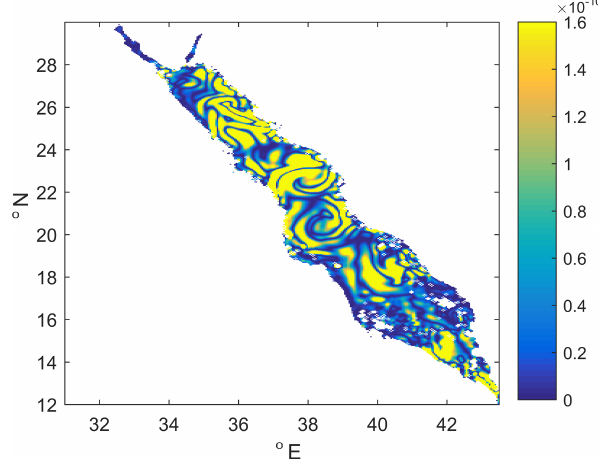
Figure 13. Distribution of local enstrophy of surface currents (s − 2 ) in the Red Sea on 1 April 2017 estimated from SMORS